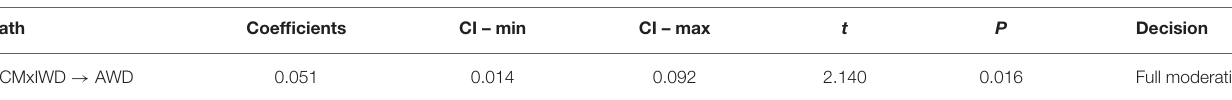
TABLE 5 | Moderating effects.